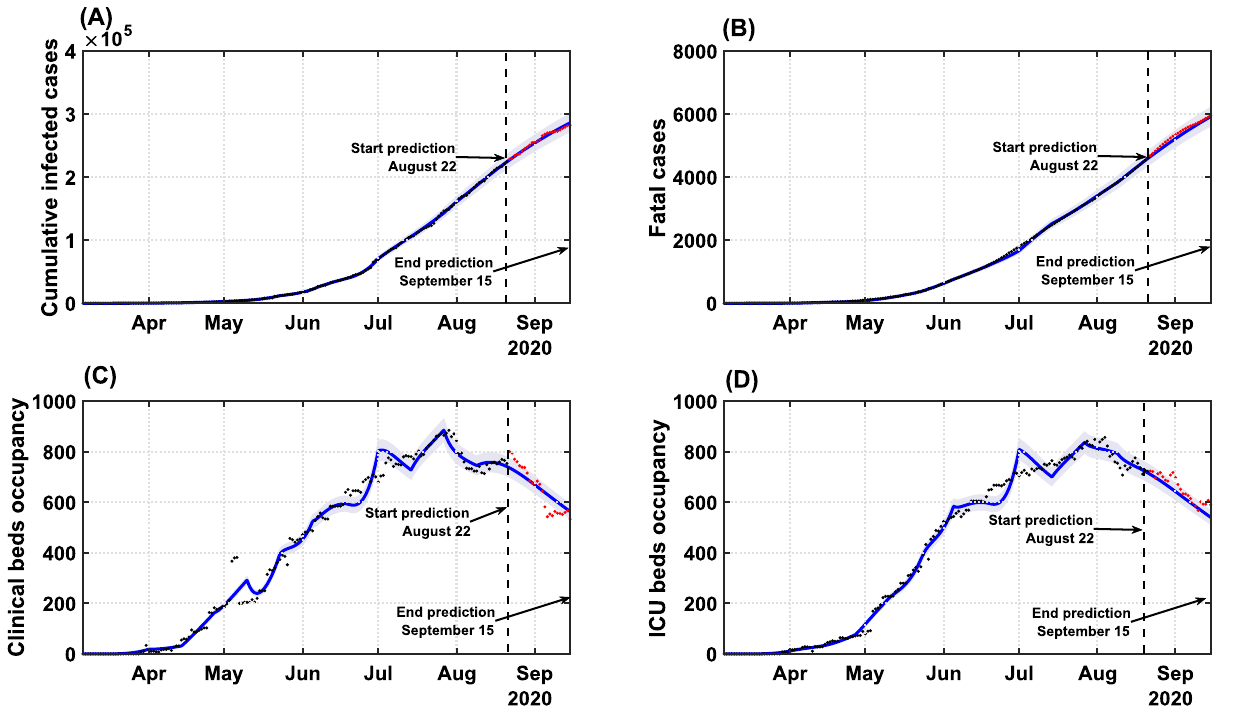
Figure 3. Model validation and forecast of the COVID-19 dynamics in Bahia. Model curves adjusted up to August 22 (blue lines), accounting for the identification procedure for g i parameters, and respective coefficient of 2 = 0.9998 2 = 0.9994 2 determination R for: ( A ) cumulative cases ( R ); ( B ) deaths ( R ); ( C ) clinical hospitalization 2 = 0.9872 2 = 0.9872 ( R ) and ( D ) ICU bed requirements ( R ) at the state level. Data beyond the dashed vertical line indicate the predicted values for the epidemiological parameters between August 22 and September 15. The shaded error bands represent 5% of the curve extrapolation margin. The assumed model parameter values are shown in Supplementary Table S4. Raw data (black dots) from March 6 to September 15, 2020, are shown in this graph with a daily